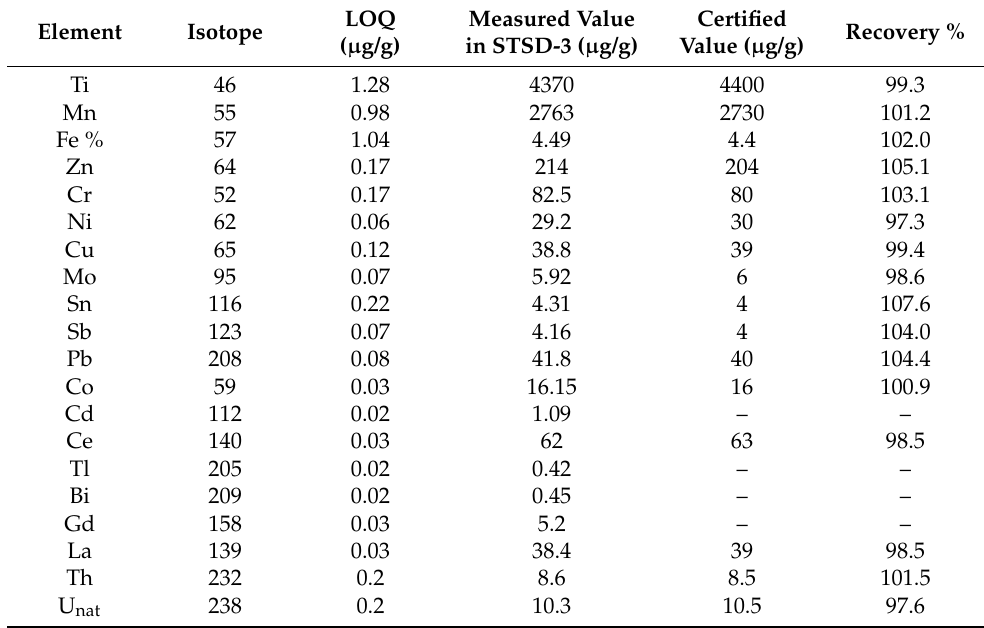
Table 8. Measured and certified values of the sediment certified reference material